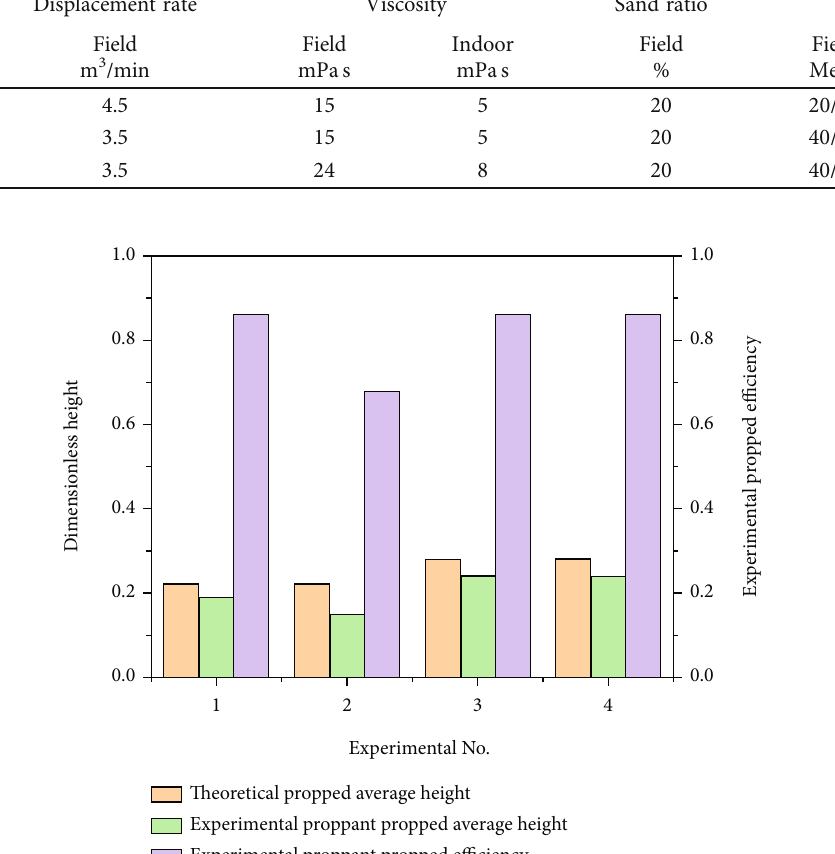
Figure 2: Comparison of current parameter placement results.